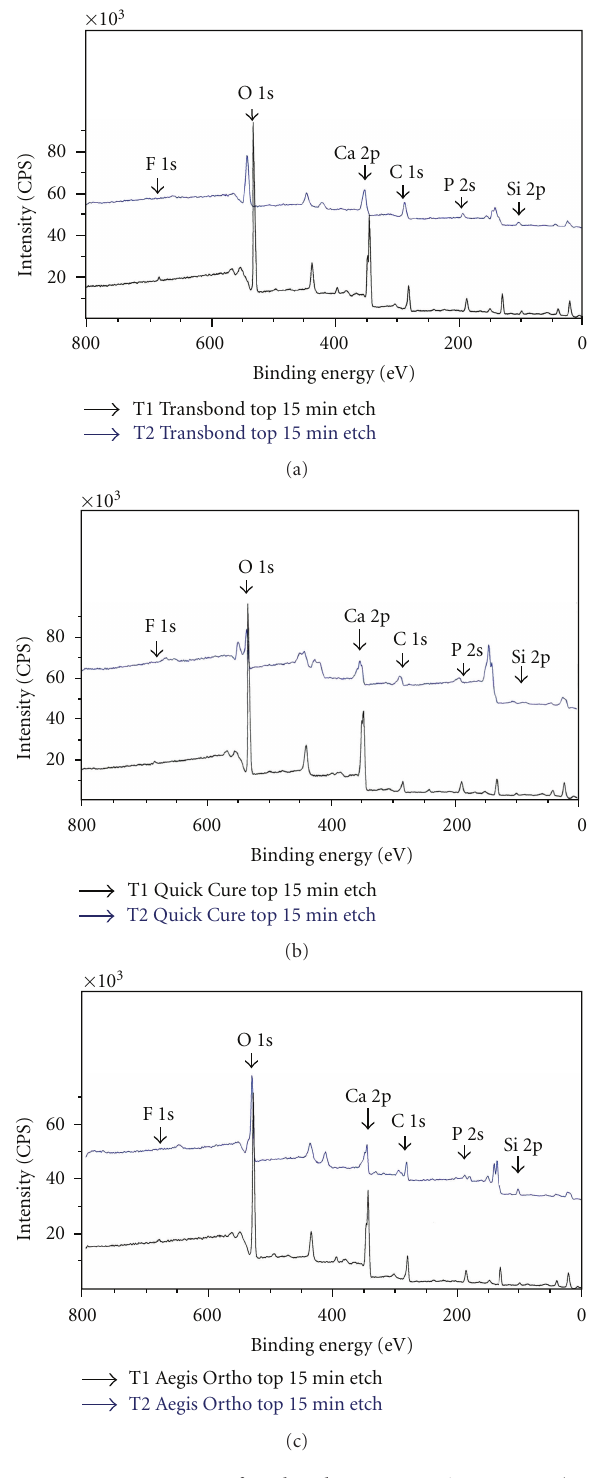
Figure 3: XPS output for the three composite groups (top, Transbond; middle, Quick Cure; bottom, Aegis Ortho) after surface sputter cleaning for 15 minutes to remove atmospheric carbon. Areas under the peaks illustrate the mass concentration percentage present for each element [calcium 2p (Ca 2p), phosphorus 2s (P 2s), oxygen 1s (O 1s), fluorine 1s (F 1s), silicon 2p (Si 2p), and carbon 1s (C 1s) electron orbits]. For Aegis Ortho, carbon and silica increased from T1 to T2 in areas under the peaks and calcium